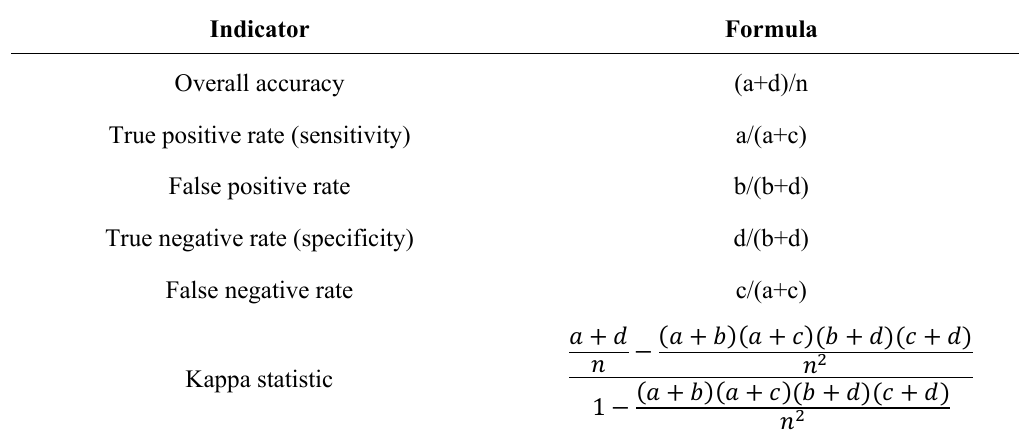
Table 3. Measures of predictive accuracy indicators for the common